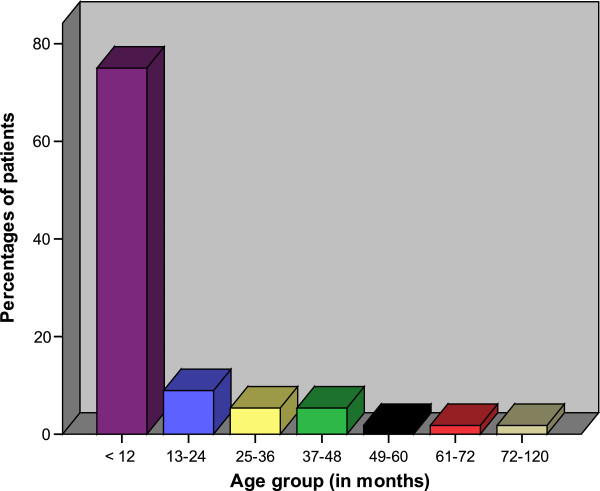
Distribution of patients according to age group.